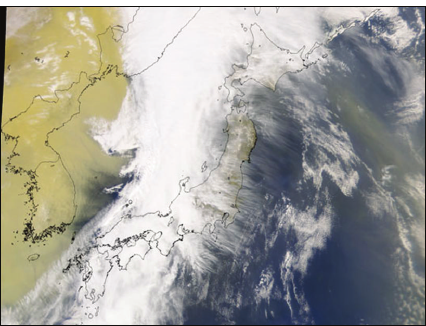
Figure 4: MODIS Terra image for 21 March, 2002, dust storm. Dust is lighter than the background in this true color MODIS-Terra